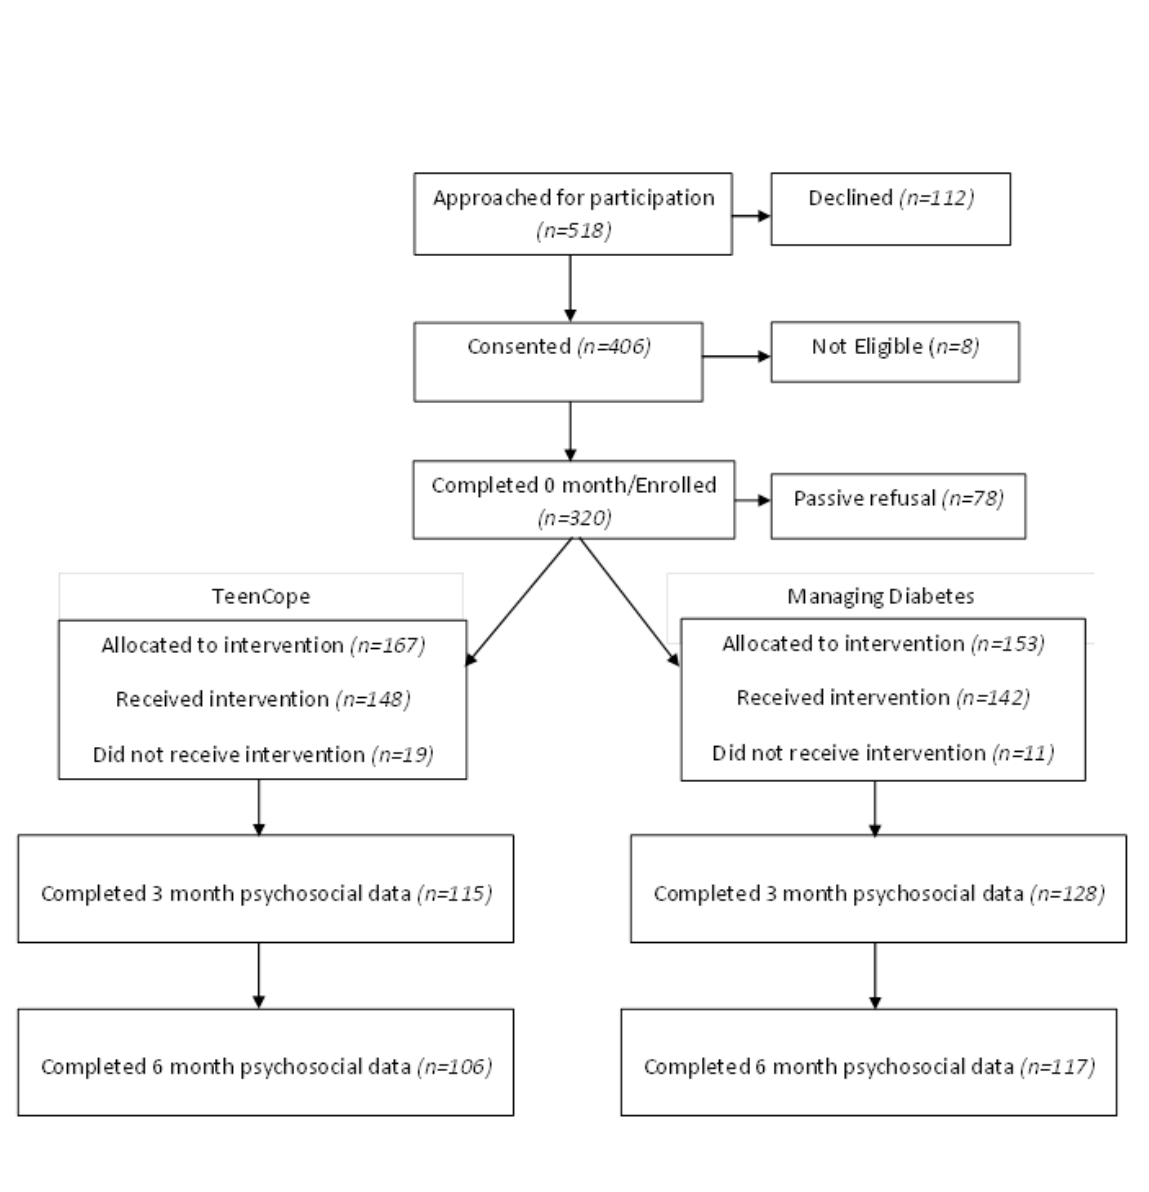
Figure 5. Consort flow